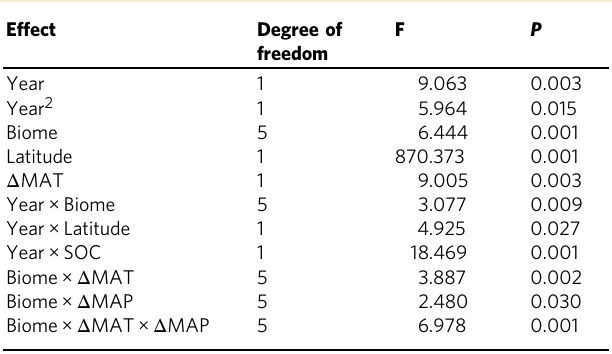
Table 1 Summary of the effects in the linear model of R S during 1987 – 2016 a .